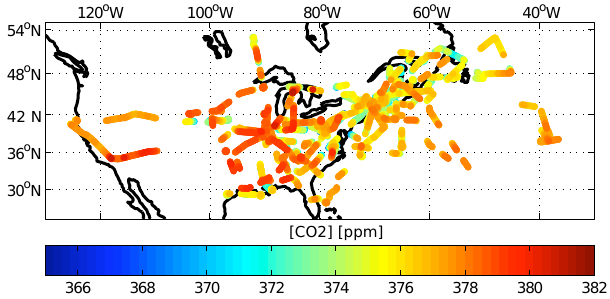
Fig. 2. Flight tracks in the free troposphere (350–800hPa) during INTEX-NA during July–August 2004. Free tropospheric CO 2 is highly variable during these two